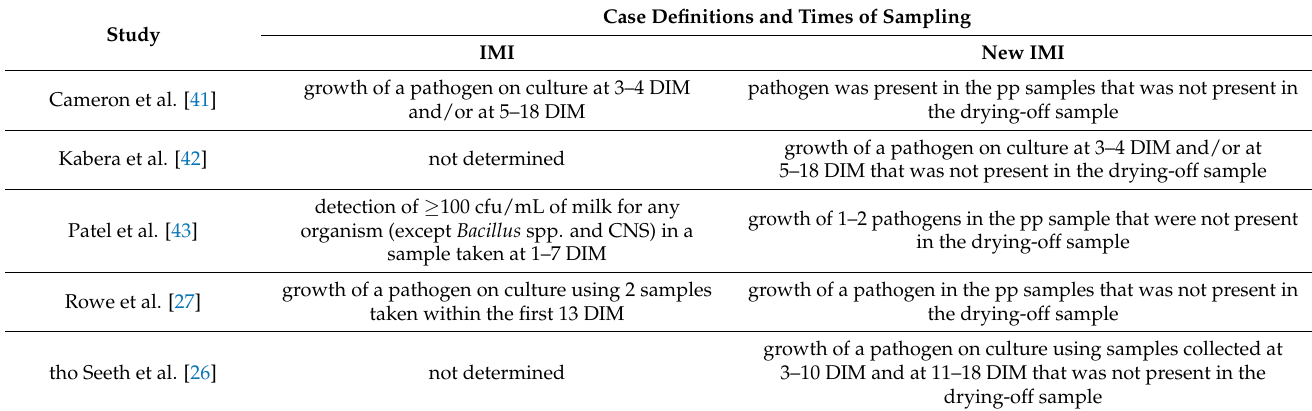
Table 2. Definitions of intramammary infections (IMI) and new IMI including sampling times and number of milk samples collected for each study included in the meta-analysis.